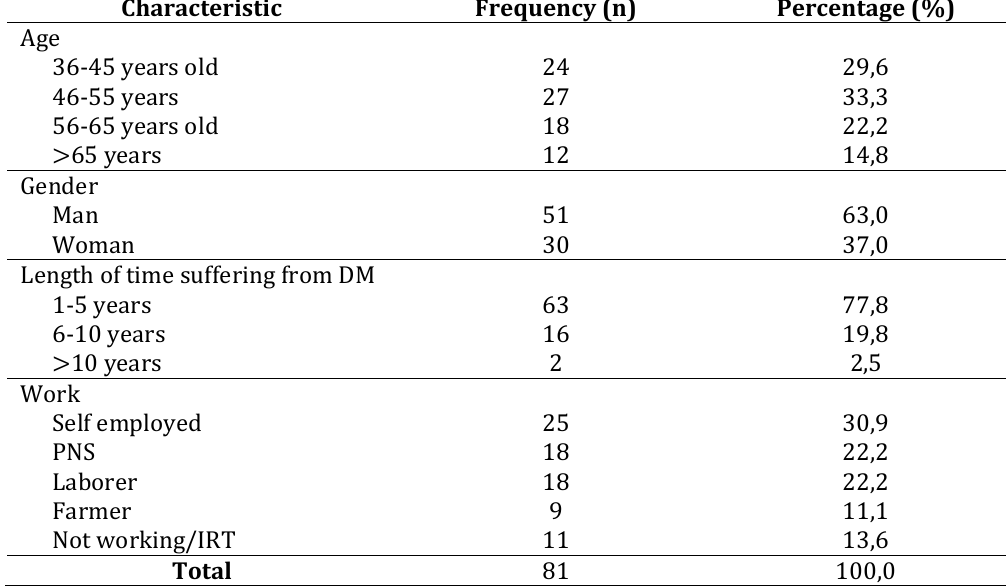
Characteristics of respondents